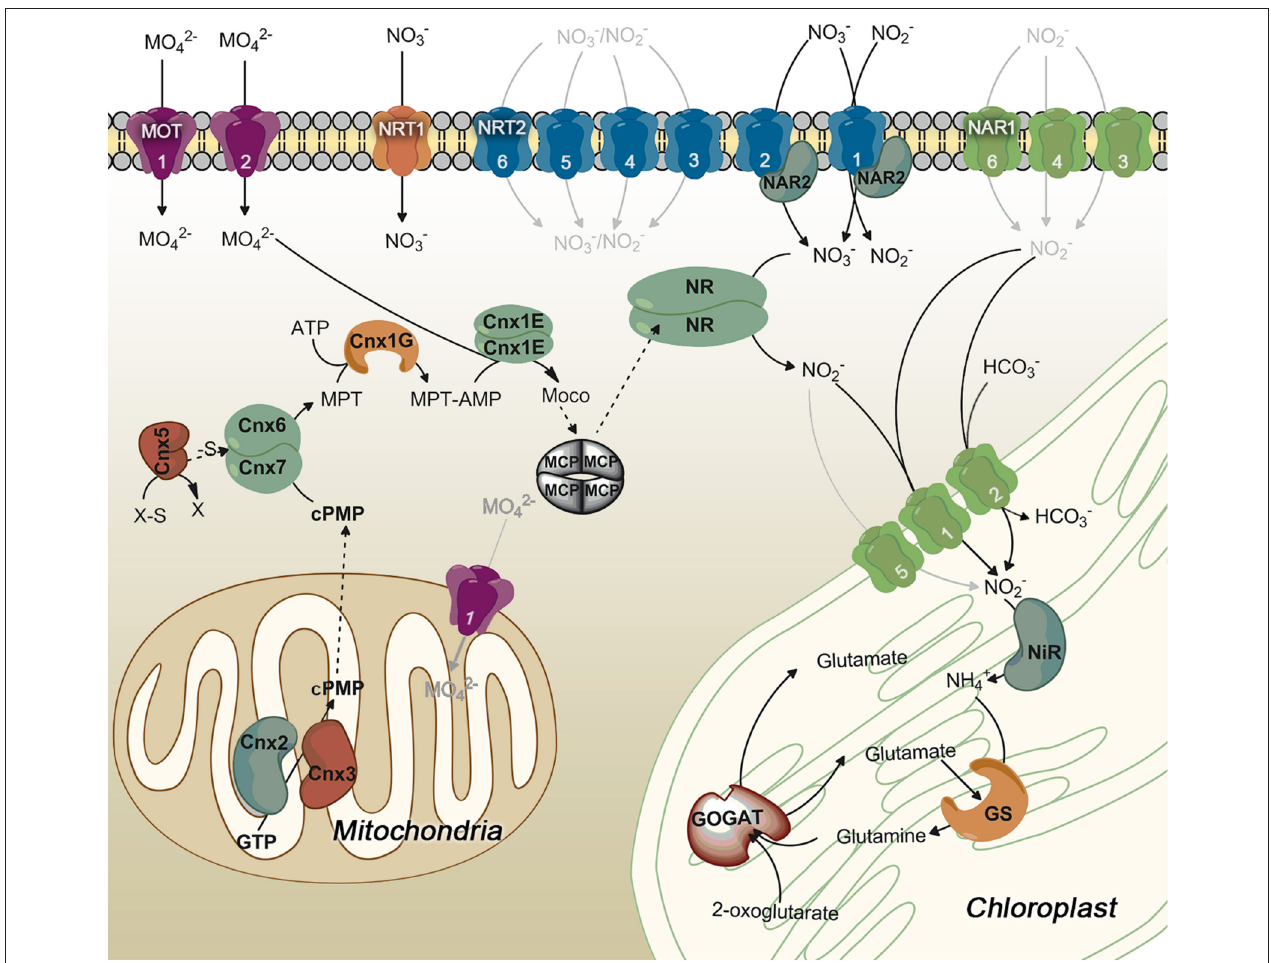
FIGURE 1 | General scheme of proteins involved in nitrate assimilation and molybdenum cofactor biosynthesis in Chlamydomonas . Those steps symbolized in gray lines are not empirically demonstrated. Proteins that mediate these hypothetic steps are represented in the most probable localization. Different colors are used for each family of transporters. Numbers on the transporters identify each family